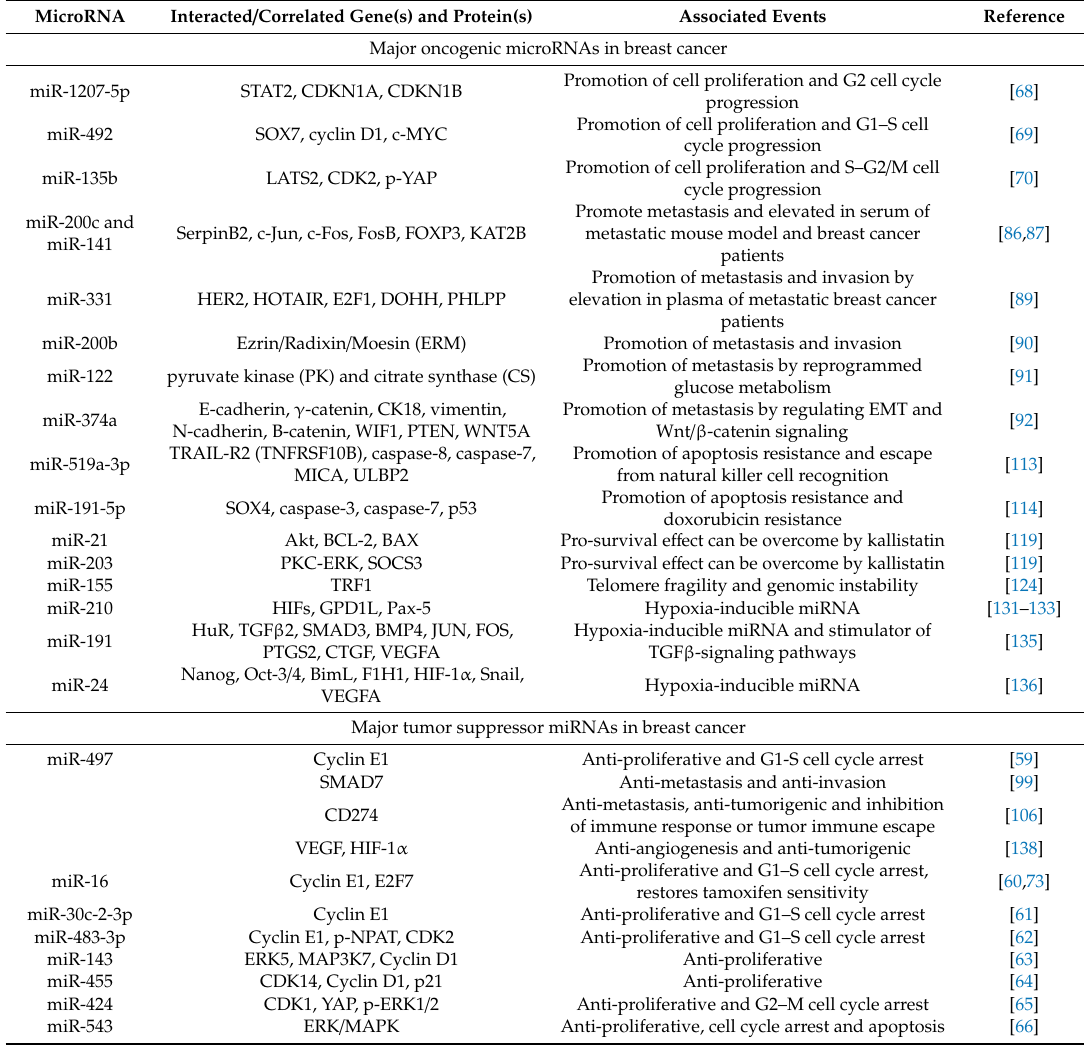
Table 1. MicroRNAs involved in the regulation of breast